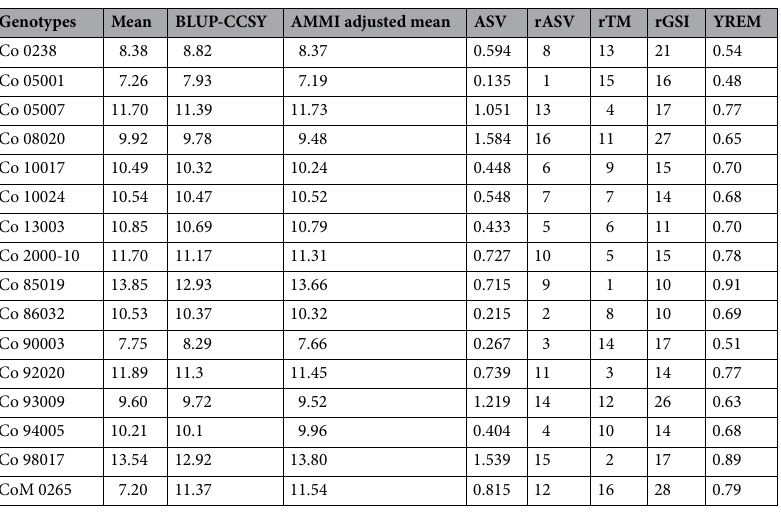
Table 4. Comparative mean performance, BLUP, AMMI stability indices for CCS yield (t/ha) under drought stress in sugarcane. BLUP best linear unbiased prediction, CCSY commercial cane sugar yield (t/ha), ASI